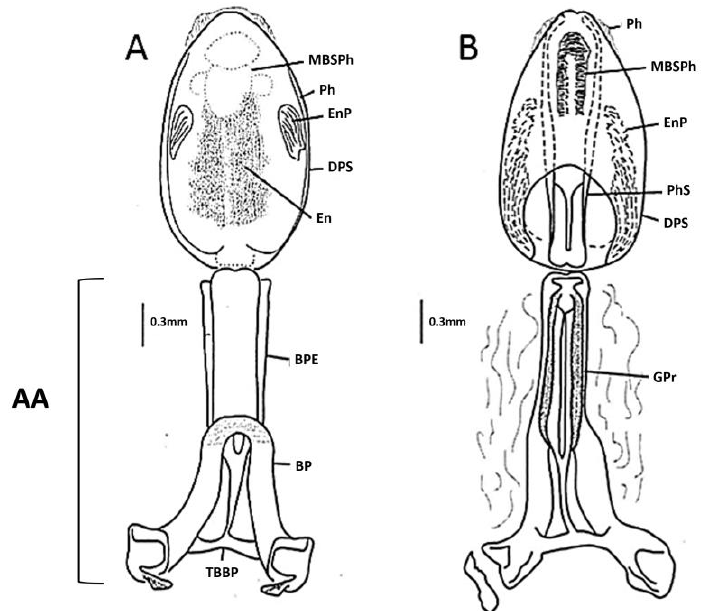
Figure 6. Phallus of Triatoma yelapensis sp. nov. ( A ) Dorsal view. ( B ) Ventral view. Abbreviations: articulatory apparatus (AA); basal plate (BP); basal plate extension (BPE); dorsal phallotecal sclerite (DPS); endosoma (En); endosomal process (EnP); gonopore process (GPr); medial basal sclerite of phallosoma (MBSPh); phallosoma (Ph); transverse bridge of basal plate (TBBP); phallosoma support